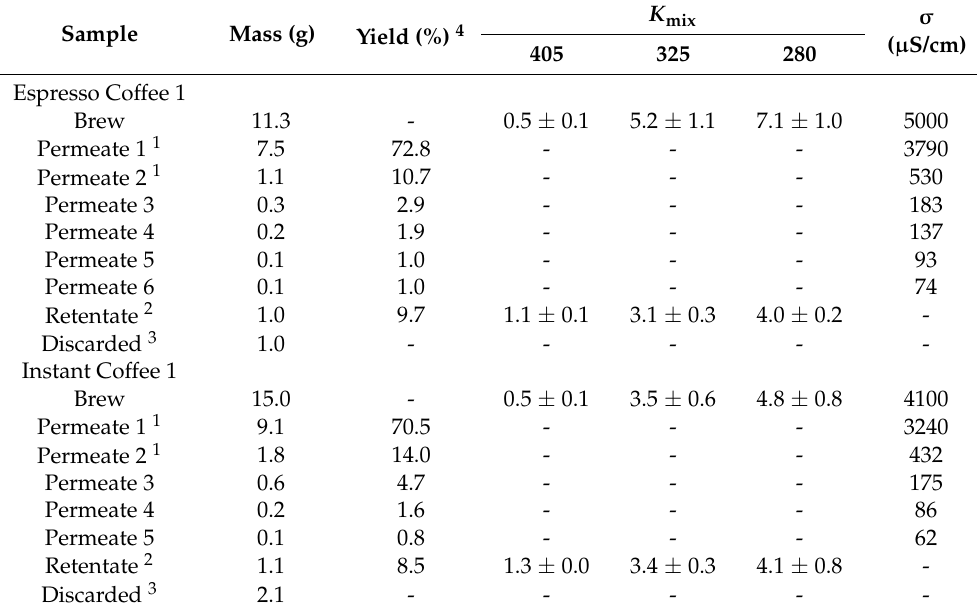
Table 1. Ultrafiltration data—mass, yield of recovery, specific extinction coefficients ( K mix,405 nm , K mix,280 nm , and K mix,325 nm ), and conductivity ( σ ) of espresso coffee 1 and instant coffee 1 brews and derived